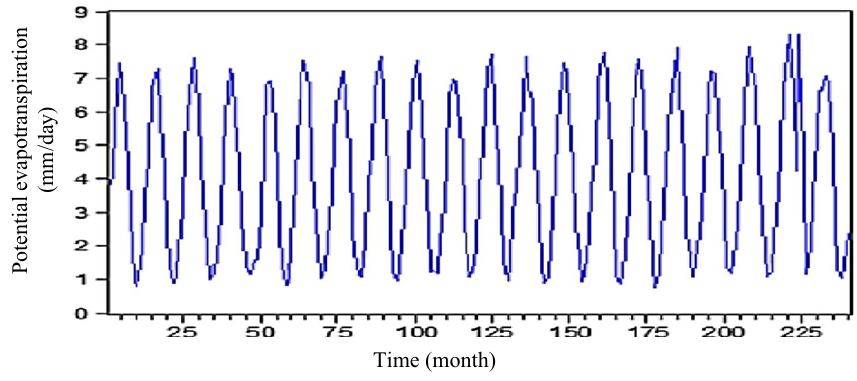
Fig. 2 Evolution-Evapotran- spiration Potential from the first month of the year 1993 to the last month of 2012 by the Hargreaves method